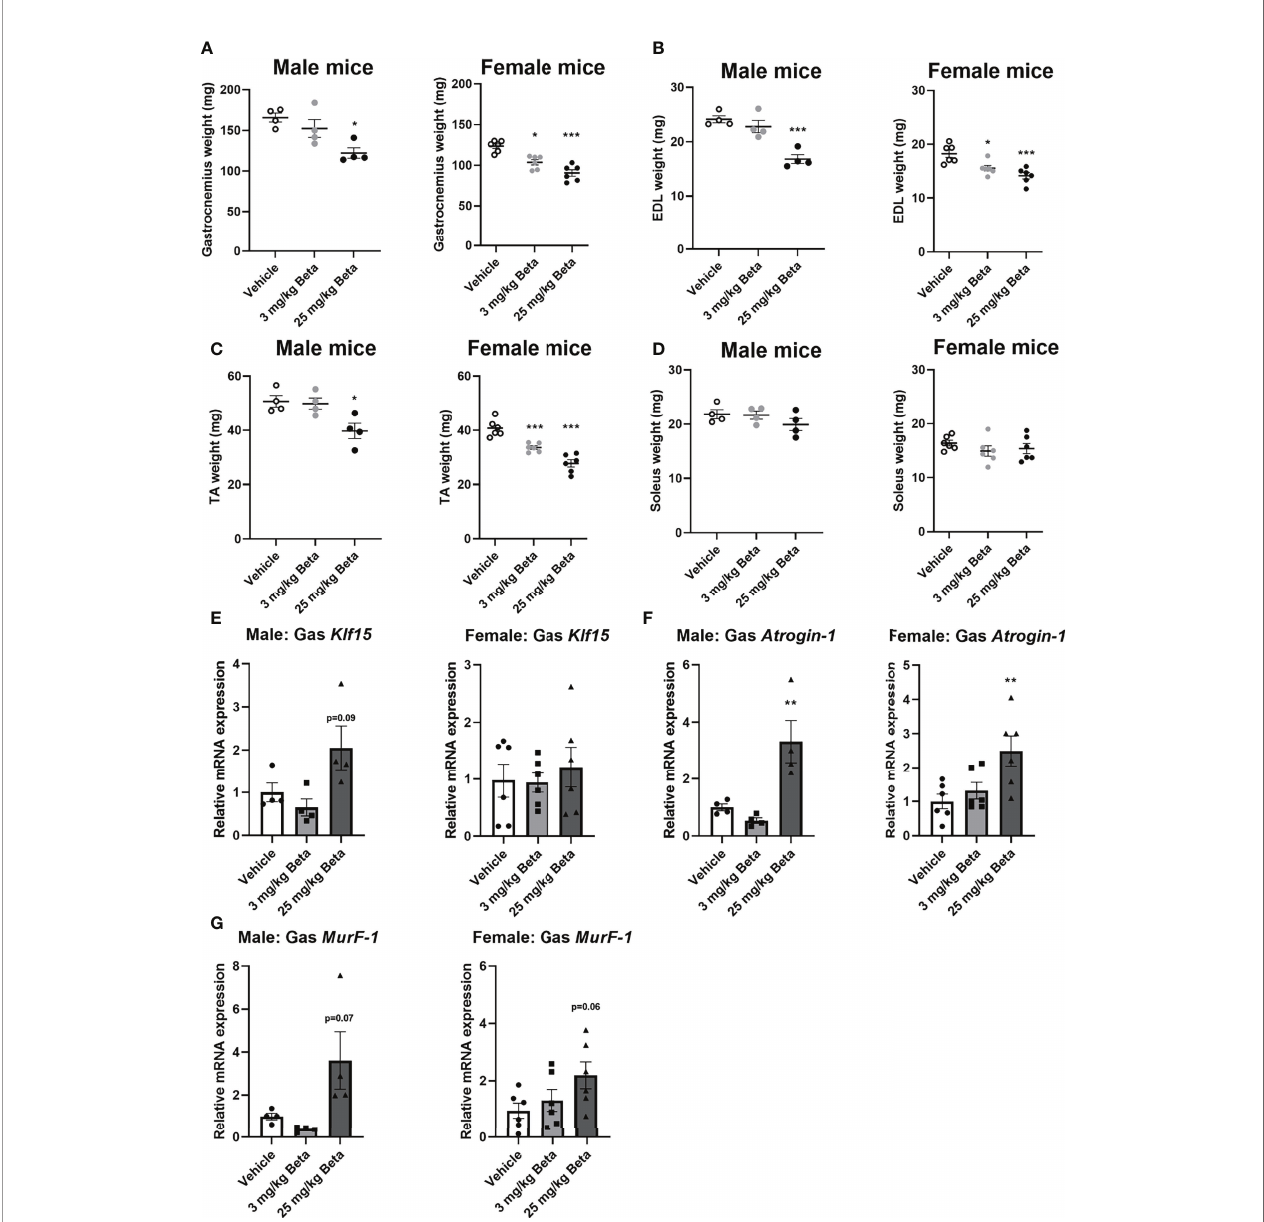
FIGURE 5 | Female mice exhibit muscle atrophy at lower doses of daily betamethasone treatment as compared to male mice. The effect of daily treatment with 3 or 25 mg/kg betamethasone on tissue weight of (A) gastrocnemius, (B) extensor digitorum longus (EDL), (C) tibialis anterior (TA) and (D) soleus. The effect of 3 or 25 mg/kg betamethasone treatment on gene expression in gastrocnemius muscle of (E) Klf15 , (F) atrogin-1 and (G) MurF-1 . N=4 male mice/group, N=6 female mice/ group. *p<0.05 vs. Vehicle, **p<0.01 vs. Vehicle, ***p<0.001 vs. Vehicle. Statistical signi fi cance was calculated using a one-way